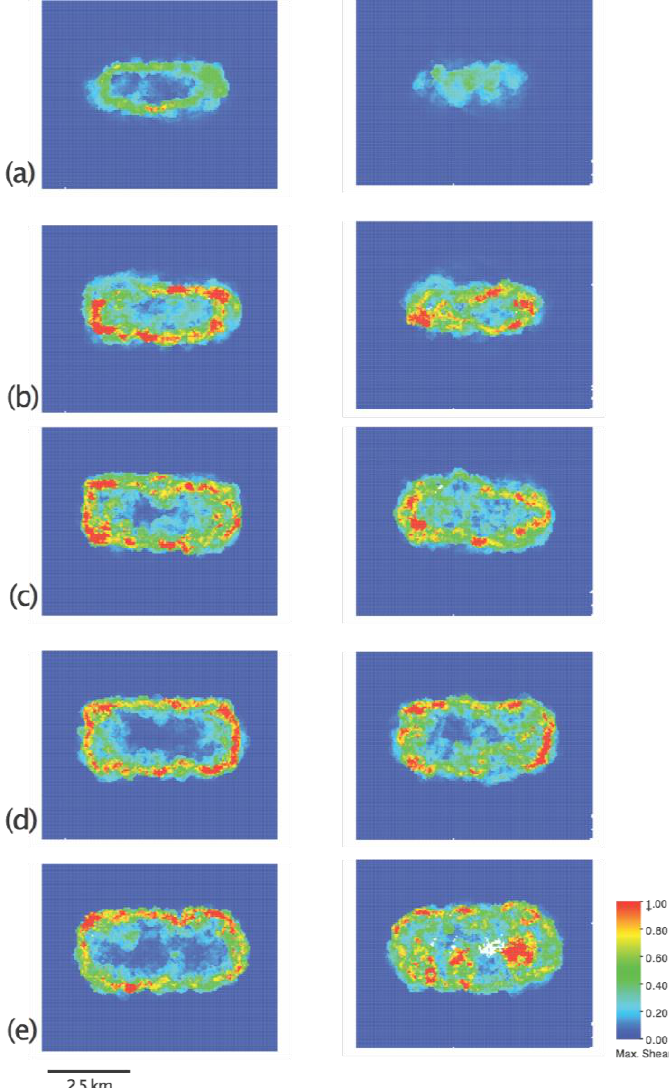
Figure 11. Evolution of horizontal sections C (left) and D (right): incremental shear strain accrued during the preceding 200 m of basal subsidence at ( a ) 200, ( b ) 400, ( c ) 600, ( d ) 800, and ( e ) 1000 m basal subsidence for an experiment with a flat, rectangular roof.